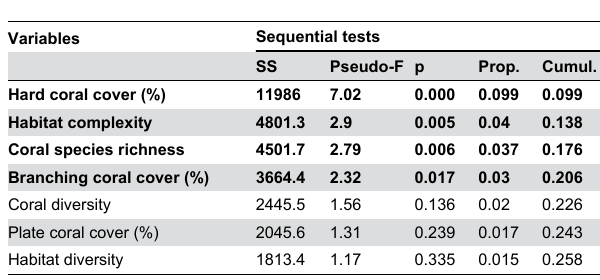
Table 4. Proportion of variance in fish taxa abundances explained by substratum predictor variables in forward